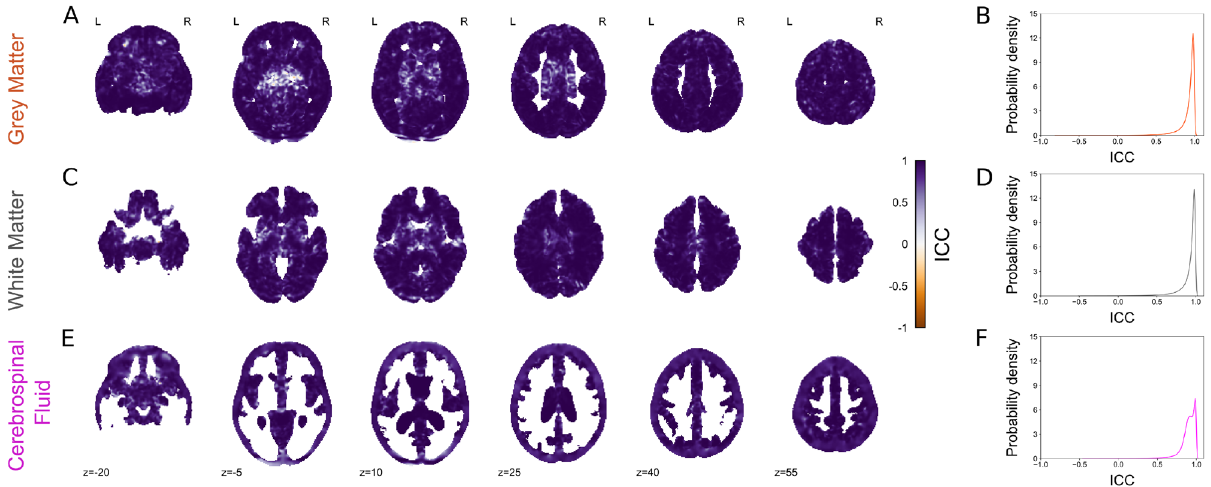
Figure 5. Test-retest reliability of EPImix (T 1 -w) tissue volume estimates. Reliability of voxel-wise volume estimates, and corresponding probability density plots, in grey matter ( A , B ), white matter ( C , D ) and CSF ( E , F ). Test-retest reliability was evaluated using the one-way random effects model for the consistency of single measurements (ICC(3,1) 29 ). Only voxels with at least 0.001 mm 3 tissue volume in at least 95% of participants are